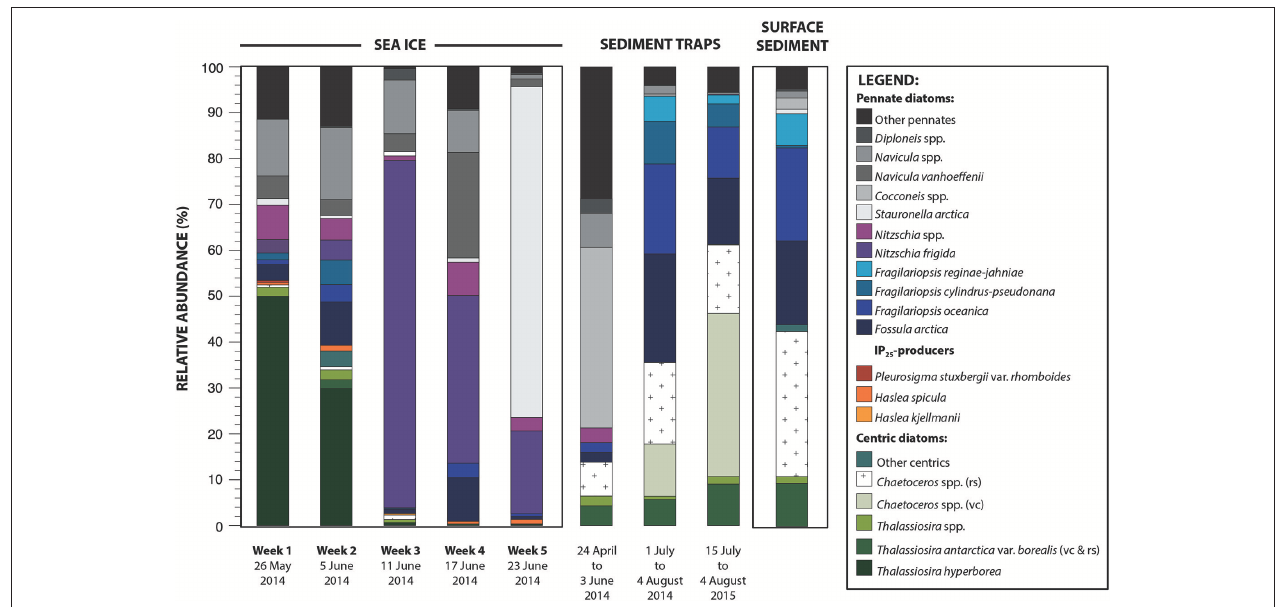
FIGURE 5 | Relative abundance (%) of the diatom taxa in the (i) sea-ice, (ii) sediment trap, and (iii) surface sediment samples. This figure illustrates the diatom succession and vertical transfer of the valves to the seafloor sediment. Sampling dates are indicated under each sample. vc, vegetative cell; rs, resting